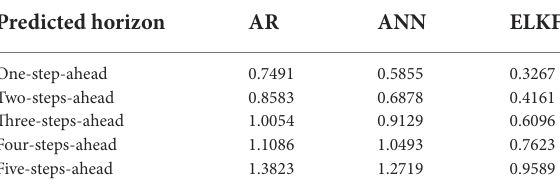
TABLE 2 Comparison of MAE values (m/s) associated with values predicted by AR, ANN, and ELKF. Predicted horizon AR ANN ELKF